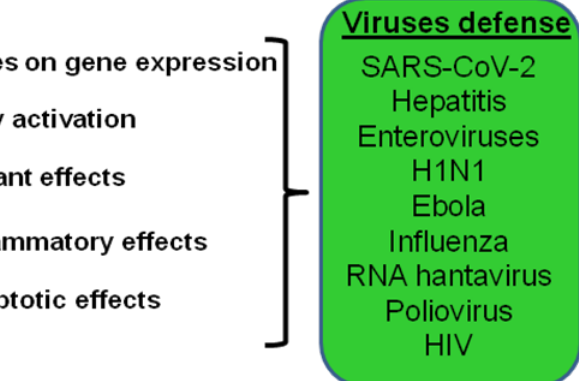
Figure 1. Schematic representation of the main pathways of antiviral action of selenium-containing agents. Protective effects refer to virus-infected cells.